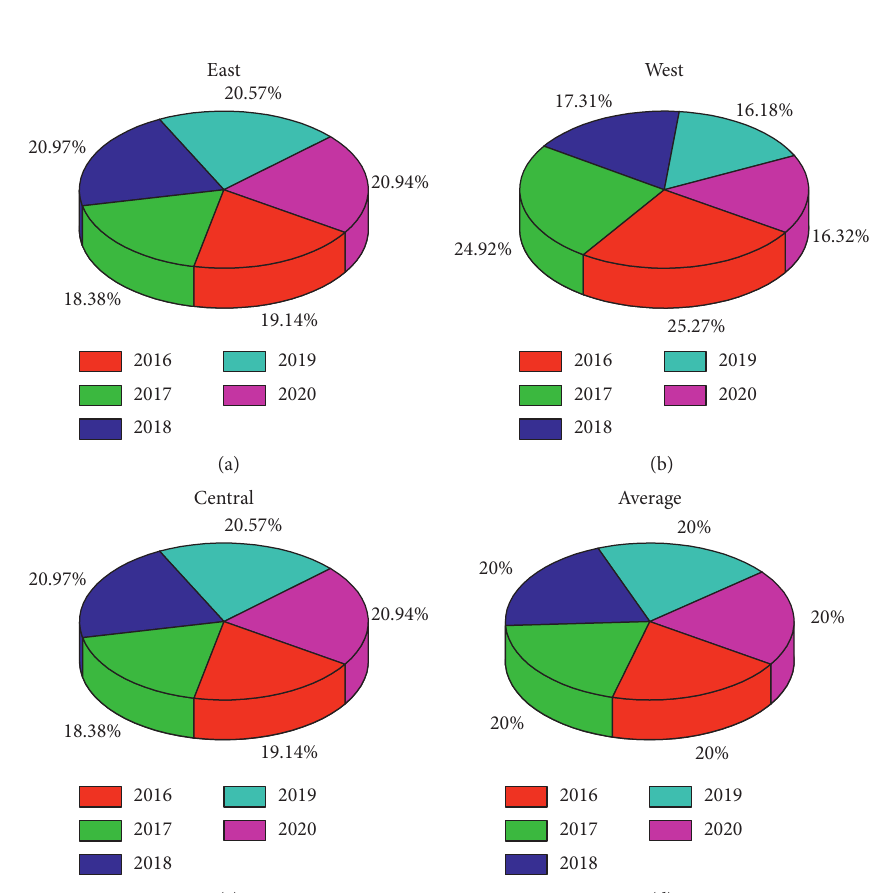
Figure 5: Comparison of Dagum’s Gini coefficient and its decomposition results in pie charts. (a) East. (b) West. (c) Central. (d)